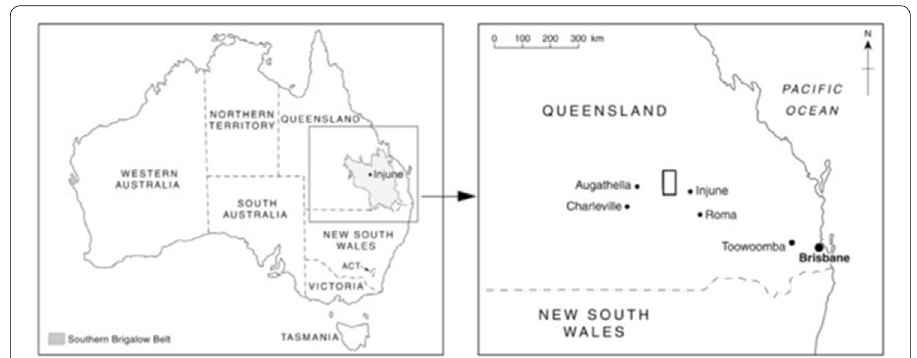
Fig. 1 Location of the Injune case study site in Queensland, Australia